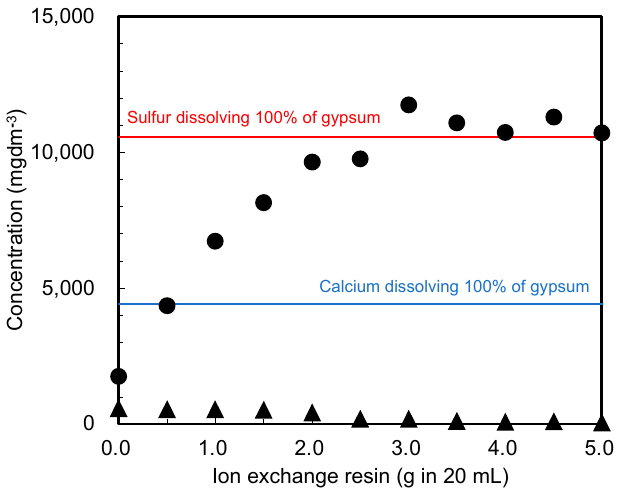
Figure 2. Sulfur and calcium concentrations in the water sample, as measured by ICP-AES after treating the gypsum reagent with a cation-exchange resin. Closed circles ( ● ): sulfur concentration, triangles ( ▲ ): calcium concentration. Colored lines: sulfur (red) or calcium (blue) after dissolving 100% of gypsum in water using the resin.